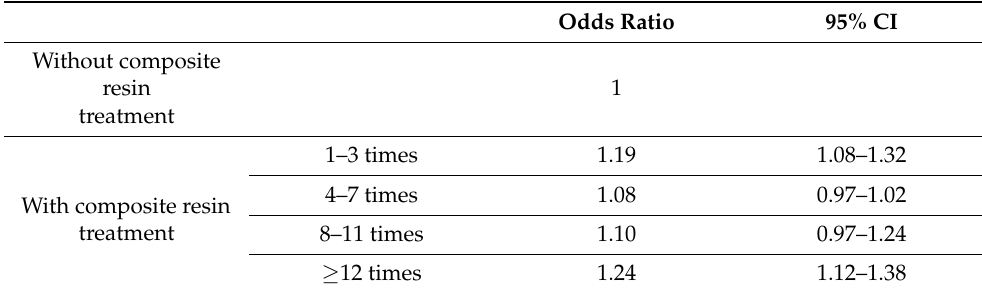
Table 3. Odds ratio for the number of composite resin restorations of those with a diagnosis of